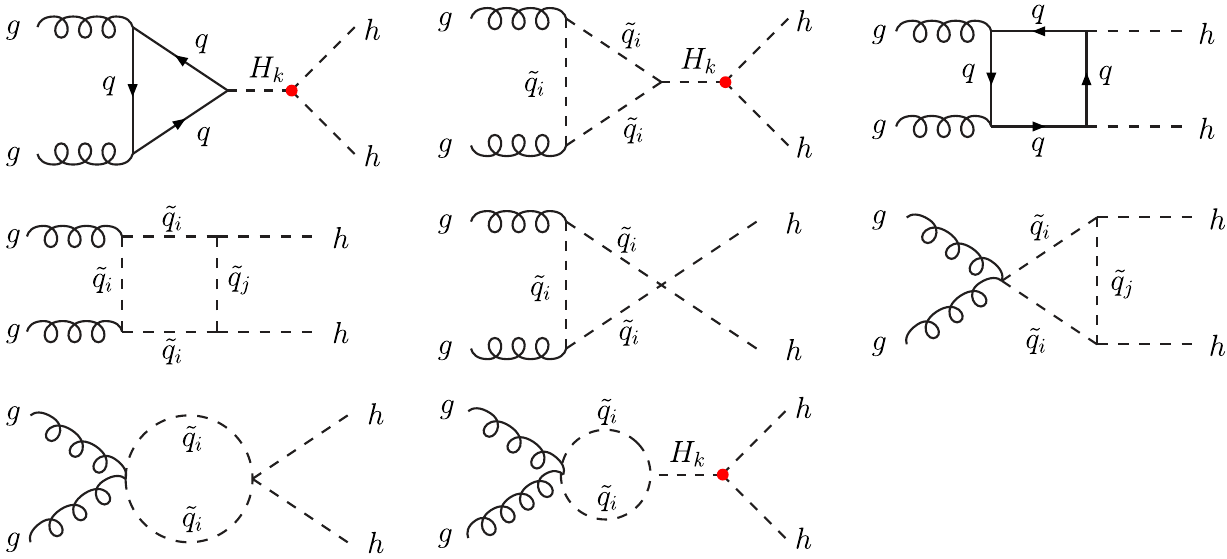
Fig. 7 Generic diagrams contributing to pair production of a SM-like NMSSM Higgs boson h in gluon fusion. The loops involve top and bot- tom (s)quarks, q = t , b , ˜ q = ˜ t , ˜ b , i , j = 1 , 2. The s -channel diagrams